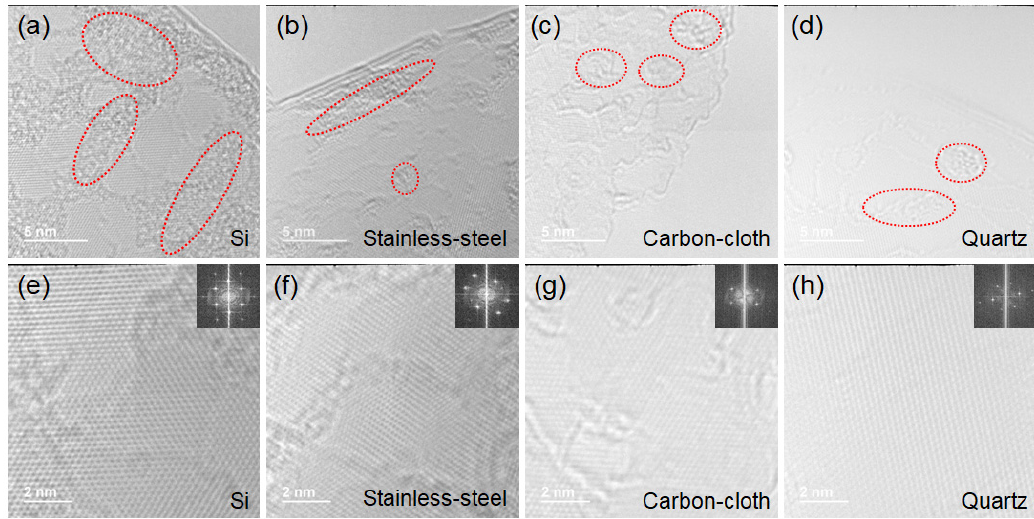
Figure 5. HRTEM images of the top area of the VFLG grown on Si, stainless-steel, flexible car- bon-cloth and quartz substrates. The insets of ( e – h ) are the diffraction patterns of the VFLG. Red circles of ( a – d ) show the typical amorphous carbon structure areas on the VFLG sheet. ( a – d ) show the typical amorphous carbon structure areas on the VFLG